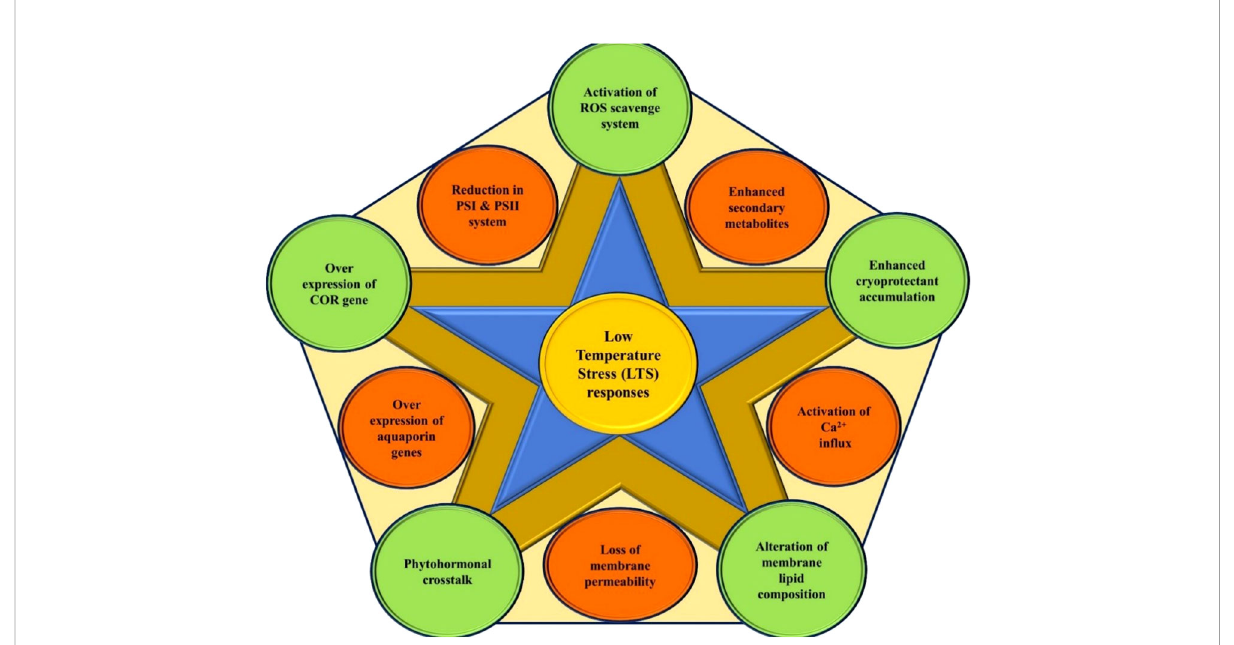
FIGURE 1 Low-temperature stress responses in plant